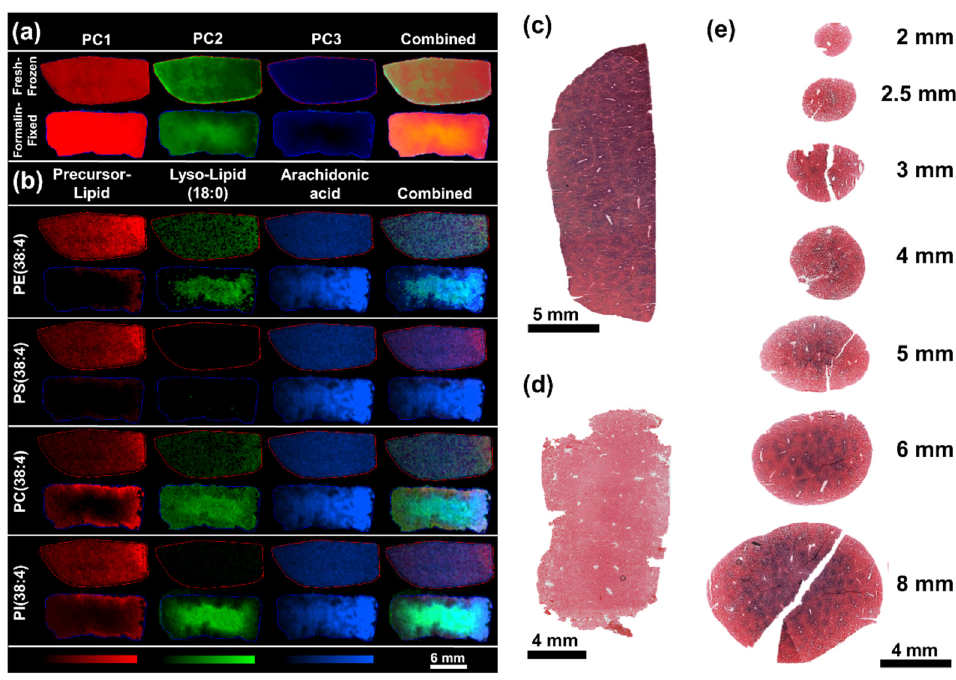
Figure 3. Comparison of representative fresh-frozen and formalin-fixed rat liver specimens. ( a ) Pixel-wise PCA of the tissue sections analyzed by DESI-MSI in negative ion mode. PC1 (red) contributed 16.65% PC2 (green) 9.38% and PC3 (blue) 5.52% of the total observed variance. ( b ) The regional differences found within the PC1–3 were found to correlate with the degradation of phospholipids in the tissue core and occurrence of the hydrolysis products lyso-lipids (18:0) and FA(20:4). ( c ) LDH stain of a frozen liver section compared to ( d ) LDH stain of a tissue section after fixation of the tissue for 24 h. ( e ) LDH stained tissue sections of rat liver punches in various sizes after 1 h of fixation.